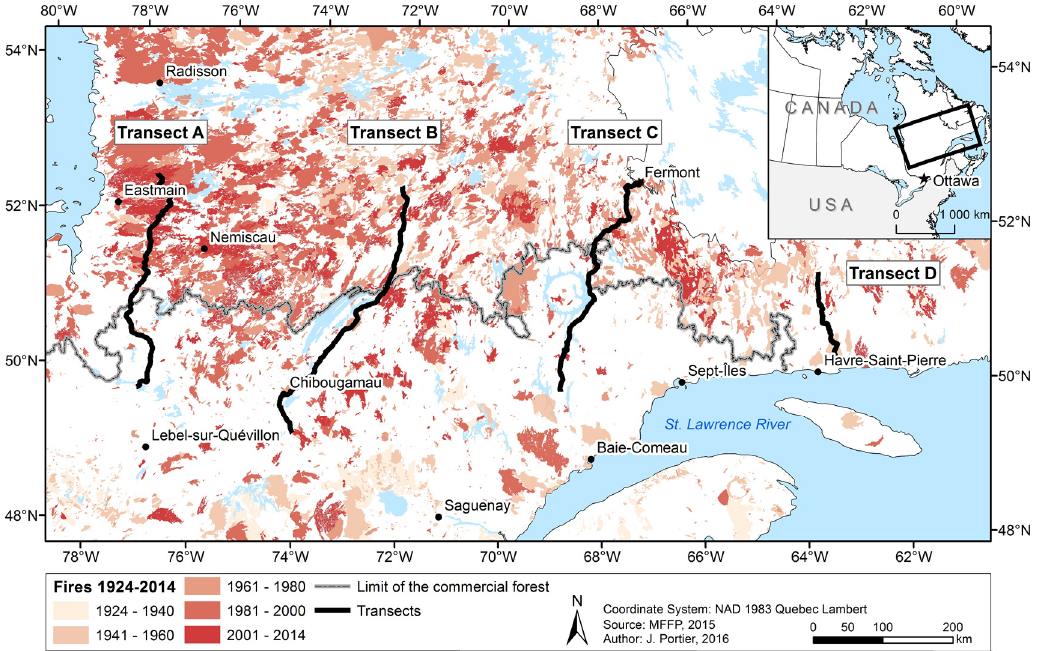
Figure A1. Map of the study area showing the four transects being analyzed, along with the recent fires from 1924 to 2014. The northern limit of the commercial forest in Quebec is also